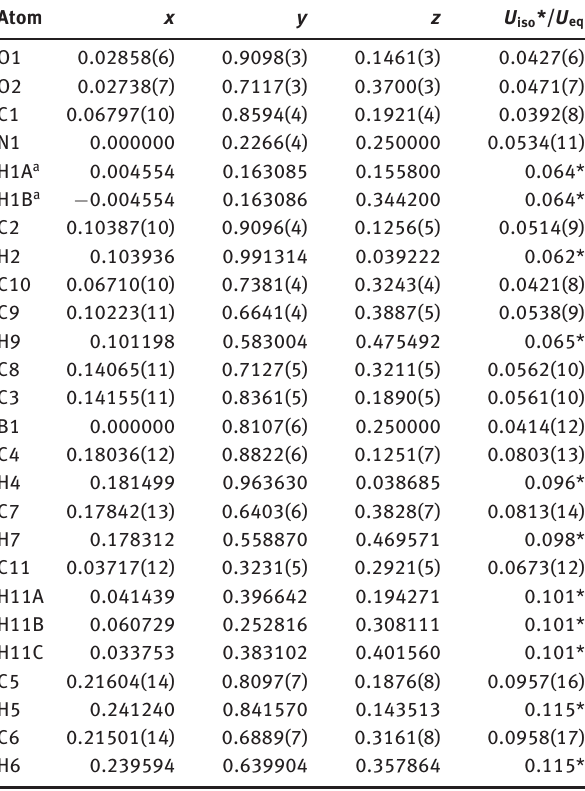
Table 2: Fractional atomic coordinates and isotropic or equivalent isotropic displacement parameters (Å 2